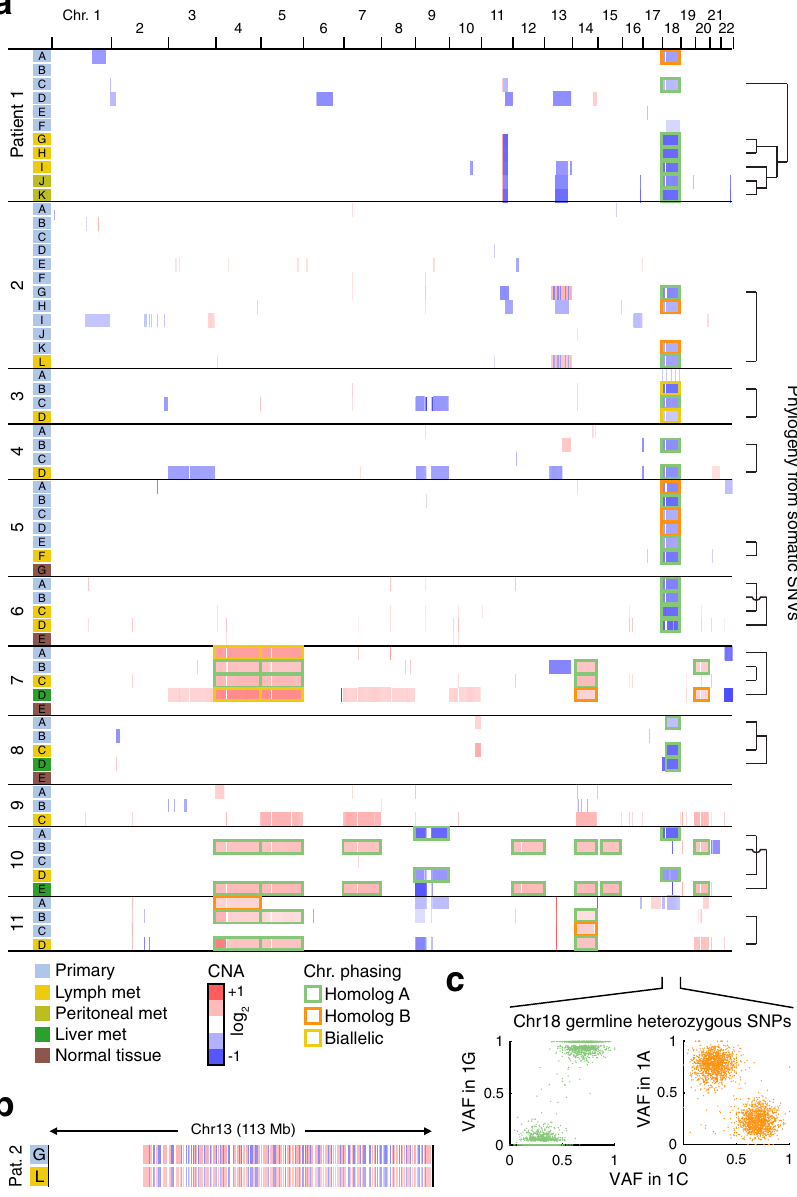
Fig. 4 Somatic copy number alterations agree with phylogenies inferred from somatic SNVs. a Somatic CNA pro fi les for all samples (blue = deletion, red = ampli fi cation; segments <25 kb were excluded for visualization purposes). Phylogenetic relationships previously inferred from somatic SNVs (Figs. 1, 2) are indicated to the right. Whole-chromosome losses and gains were phased based on germline SNPs (see Supplementary Fig. 18), with the two chromosome homologs indicated in green and orange and likely biallelic events shown in yellow. b Detailed view of chromothripsis on chr13 in Patient 2, present in the metastatic primary (G) and the metastasis (L). c Example of phasing of chr18 deletions in Patient 1. Met, metastasis; Chr, chromosome. Source data are provided as a Source data fi